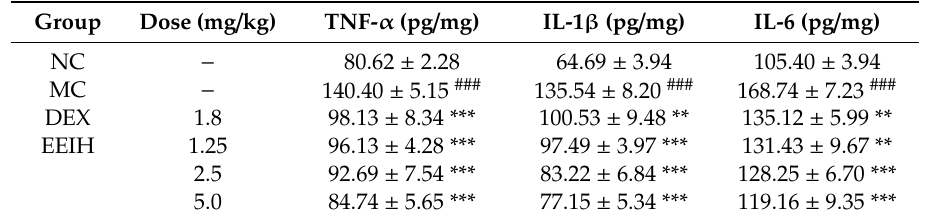
Table 4. E ff ects of EEIH on the level of proinflammatory cytokines in renal tissue of LPS-treated mice. Group